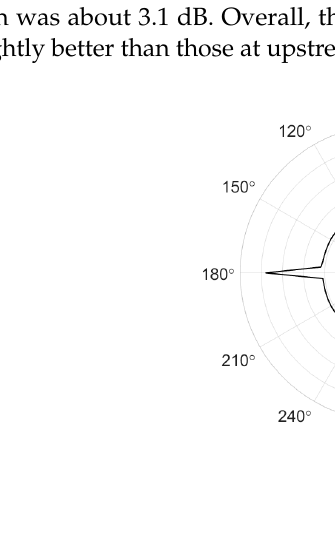
Figure 9. OASPL-reduction effects of the wavy airfoil: ( a ) directivity pattern; ( b ) OASPL reduction.